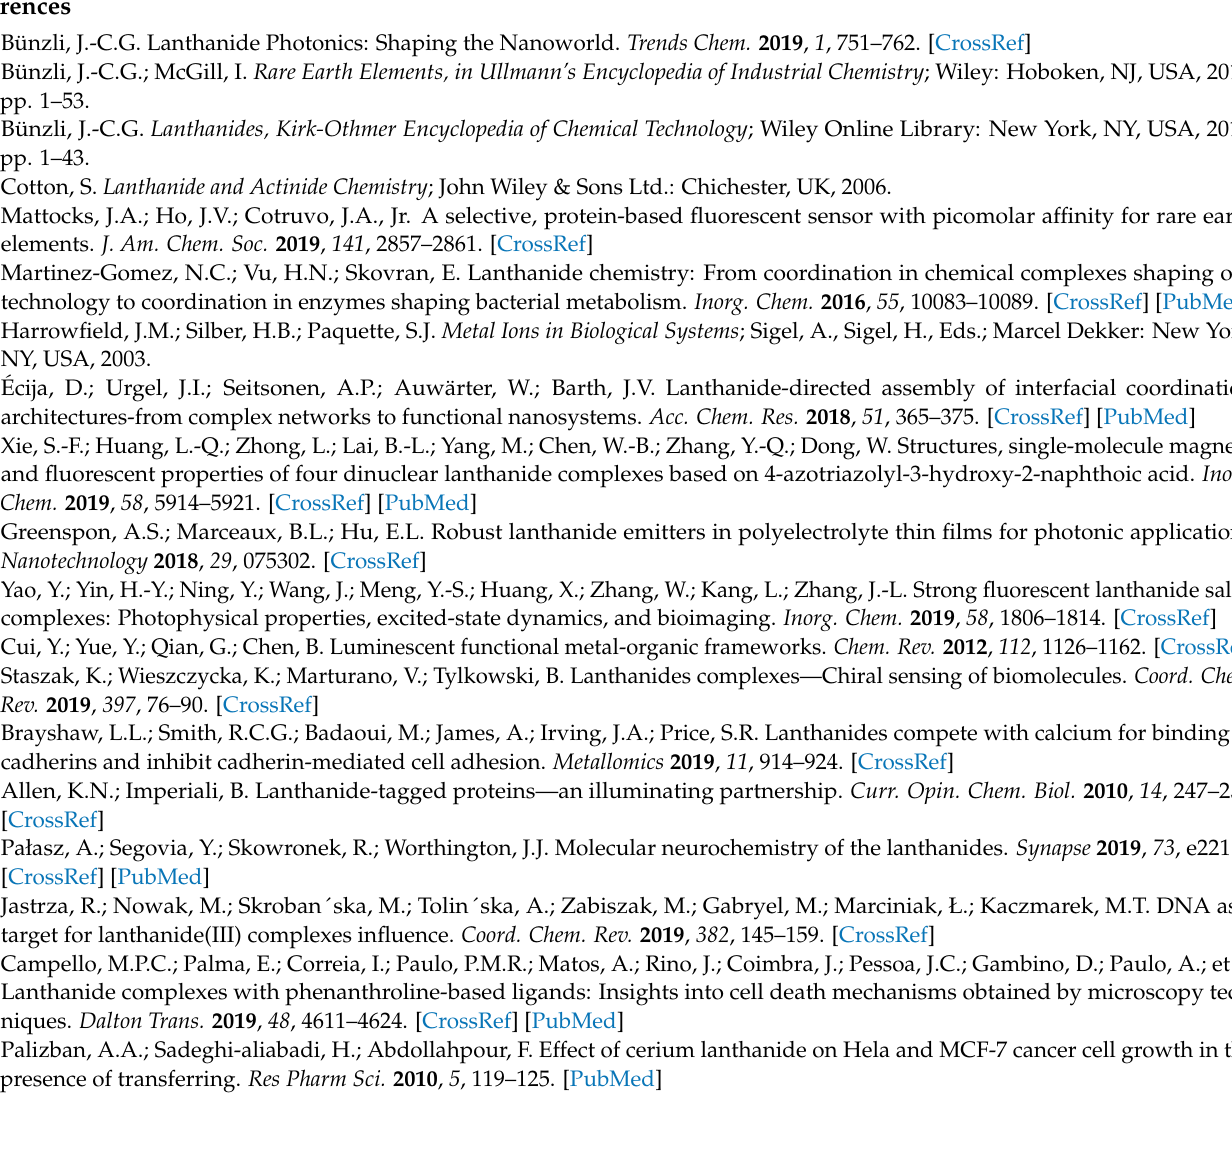
processing parameters of 1 – 10 , Figure S21: Emission spectrum of 10 measured at the 464 nm